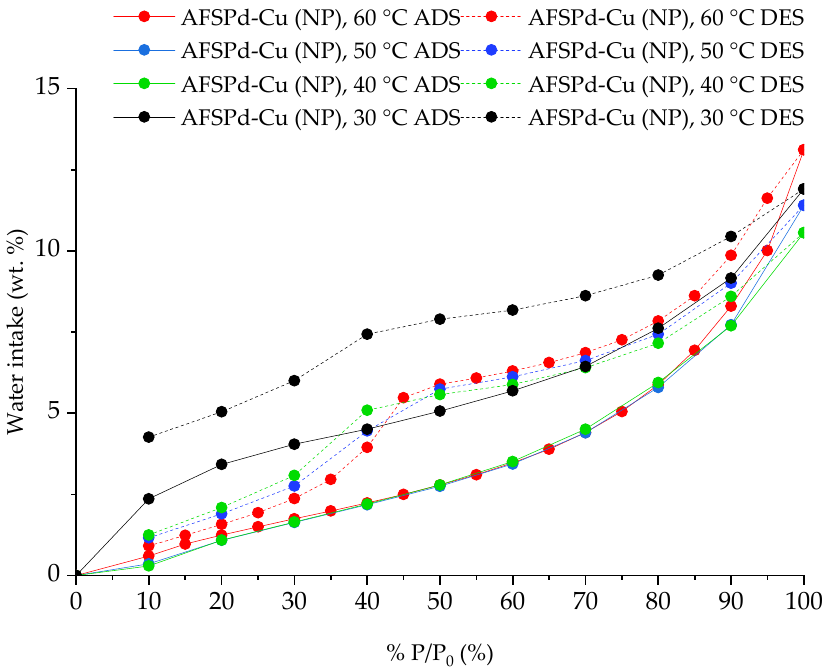
Figure 8. Adsorption and desorption isotherms for AFSPd-Cu (NP) sample, at 30, 40, 50 and 60 °C .